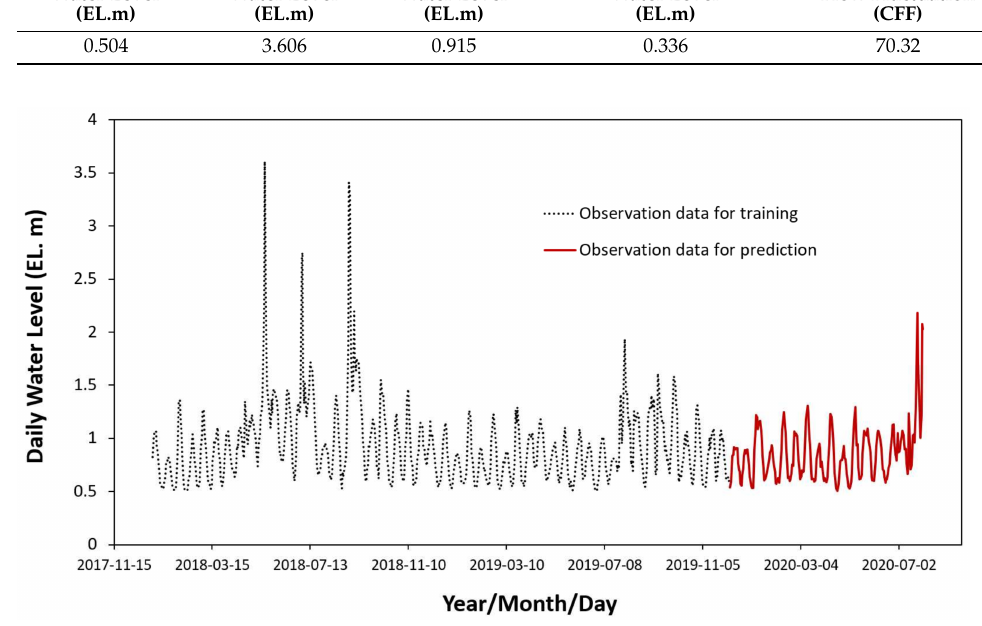
Figure 5. Time-series daily water level at the Hangang Bridge (period: